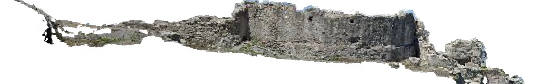
Figure 2: South-East Façade Photogrammetric Orthophoto